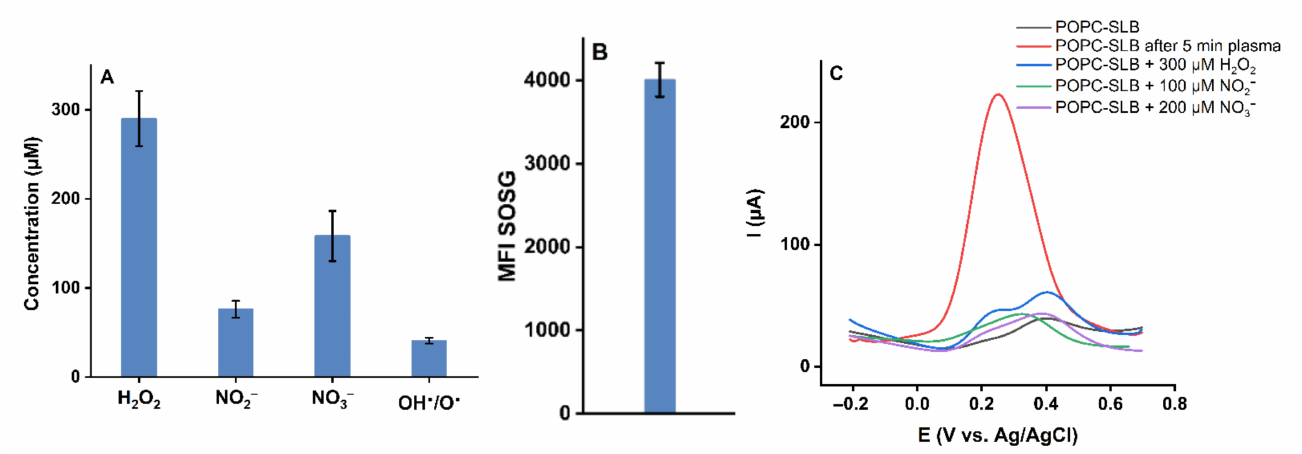
Figure 6. ( A ) Concentration of reactive species produced after 5 min plasma treatment of PBS (pH 7.4), ( B ) 1 O 2 was detected using the SOSG assay, ( C ) Differential pulse voltammograms of 10 mM K 4 [Fe(CN) 6 ] in PBS recorded for the POPC lipid bilayer after 5 min plasma treatment, and after 5 min incubation of the bilayer with selected long-lived RONS, the added concentrations matched with results from 5 min plasma